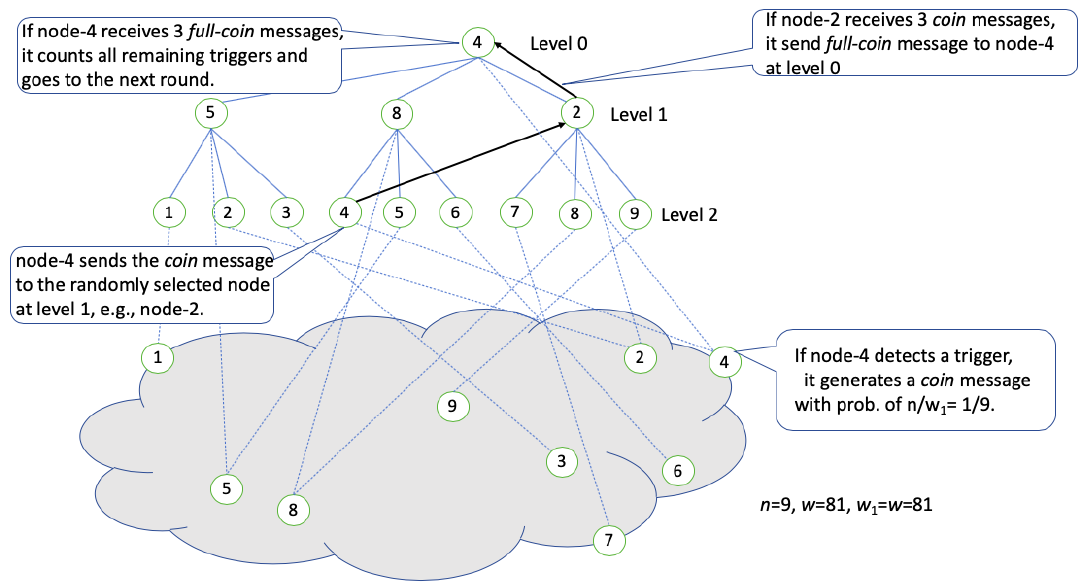
Figure 1. An example of DDR-coin in round 1 when n = 9 and w =